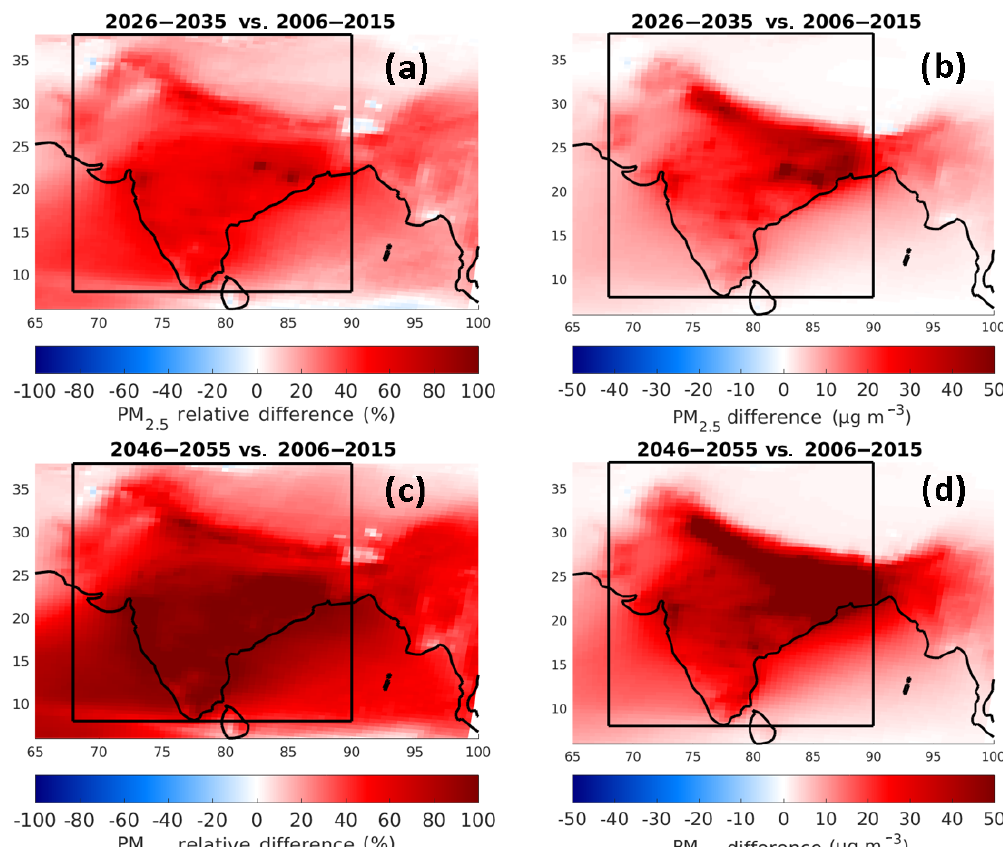
Figure 13. Distribution of the relative difference (a, c) and absolute difference (b, d) in surface PM 2 . 5 between the reference scenario and the FCE2030 scenario (a–b) and the FCE2050 scenario (c–d) . The relative differences are calculated as ([FCE – reference] / reference) × 100%, and the absolute differences as [FCE – reference]. The black box delimits the region described in the